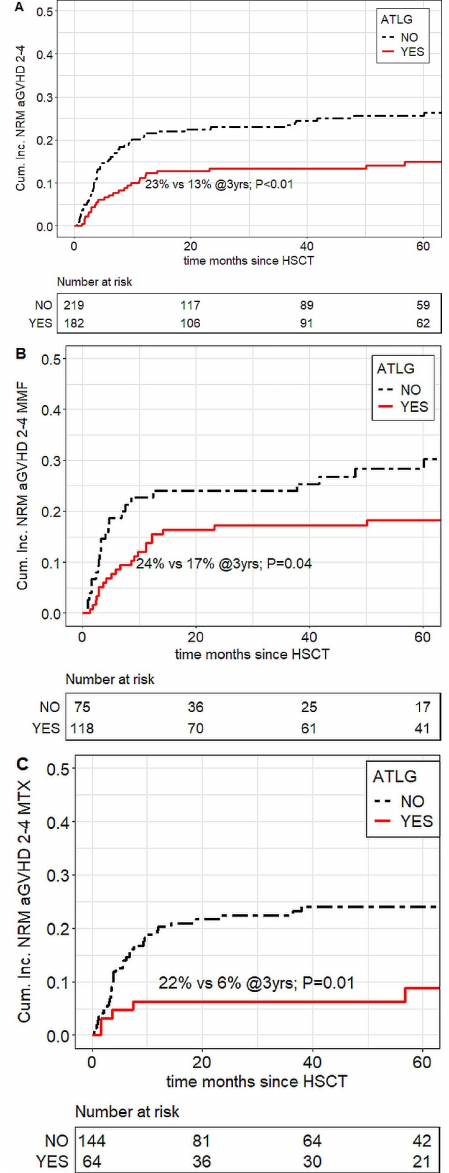
Figure 4. aGVHD-associated mortality by ATLG. Red line, ATLG; black line, no ATLG. ( A ) Entire cohort. ( B ) MMF subgroup. ( C ) MTX